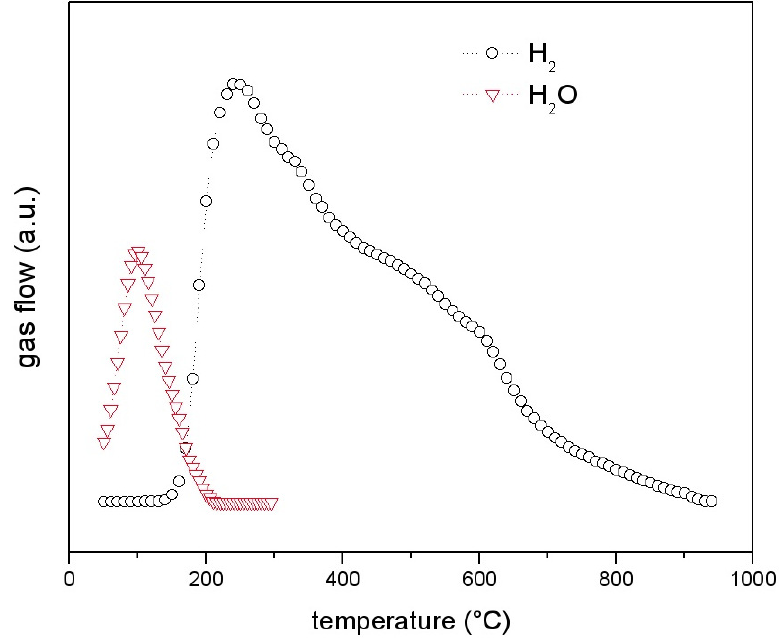
Figure 9. Thermal Programmed Desorption (TPD) analysis of LaNi consists in a low temperature (<300 °C) water flow followed by a consistent H